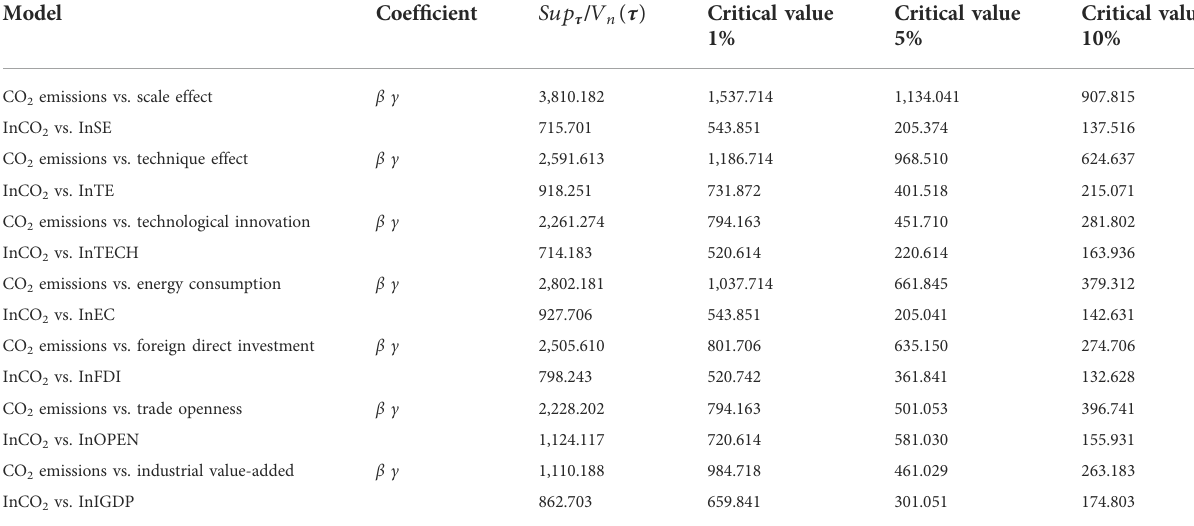
TABLE 5 Quantile co-integration test